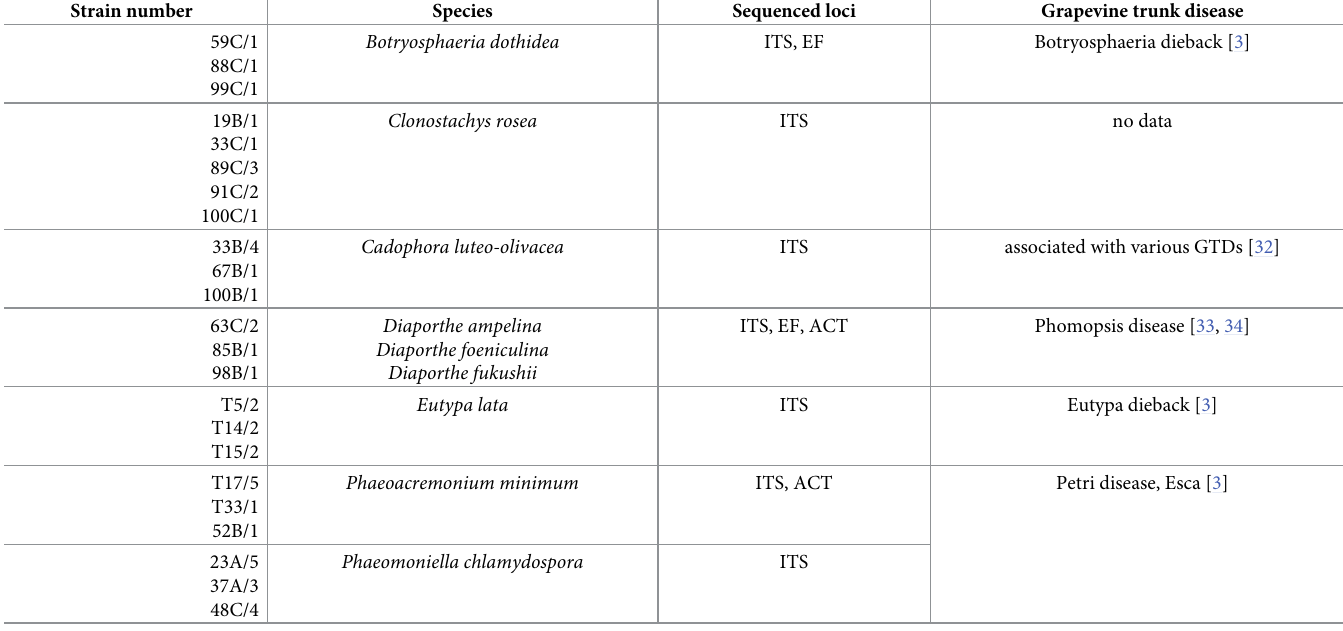
Table 1. List of the isolates used in the present study.